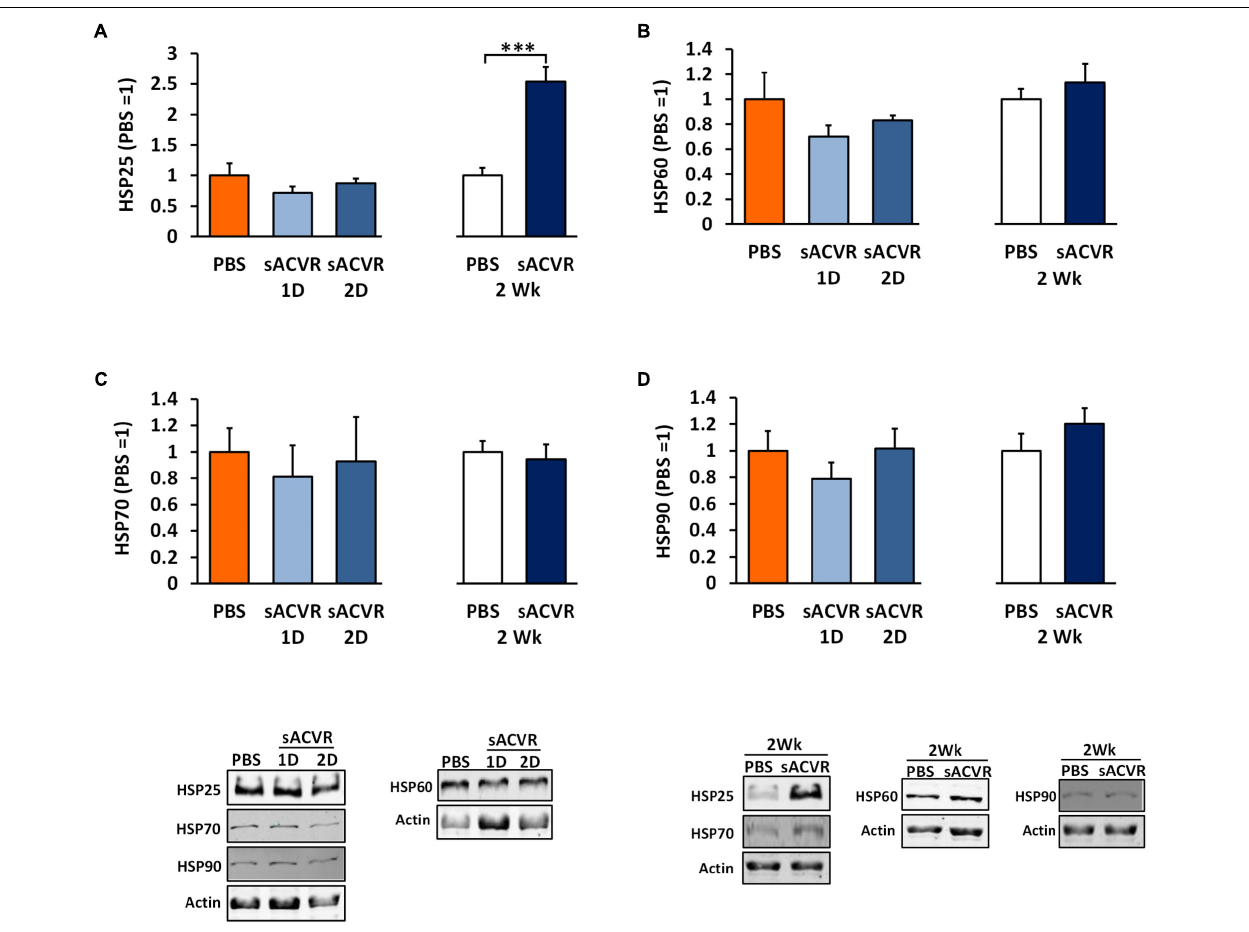
FIGURE 4 | Heat shock protein (HSP) response markers in healthy skeletal muscle in mice that were administered with soluble activin receptor type 2B (sACVR) or vehicle (PBS). Muscles were collected 1 or 2 days after a single sACVR administration or after 2 weeks of administration. (A) HSP25, (B) HSP60, (C) HSP70, and (D) HSP90; n = 6–7 in all groups except n = 10–11 in sACVR 2 Wk group. The symbol ∗∗∗ depicts statistical significance p < 0.001. Data is expressed as means ± SE. Representative blots were cropped from the original blot images ( Supplementary Figure 8 ). Representative blots with same IDs and analyzed in the same run are aligned on top of each other and share the same representative control blot